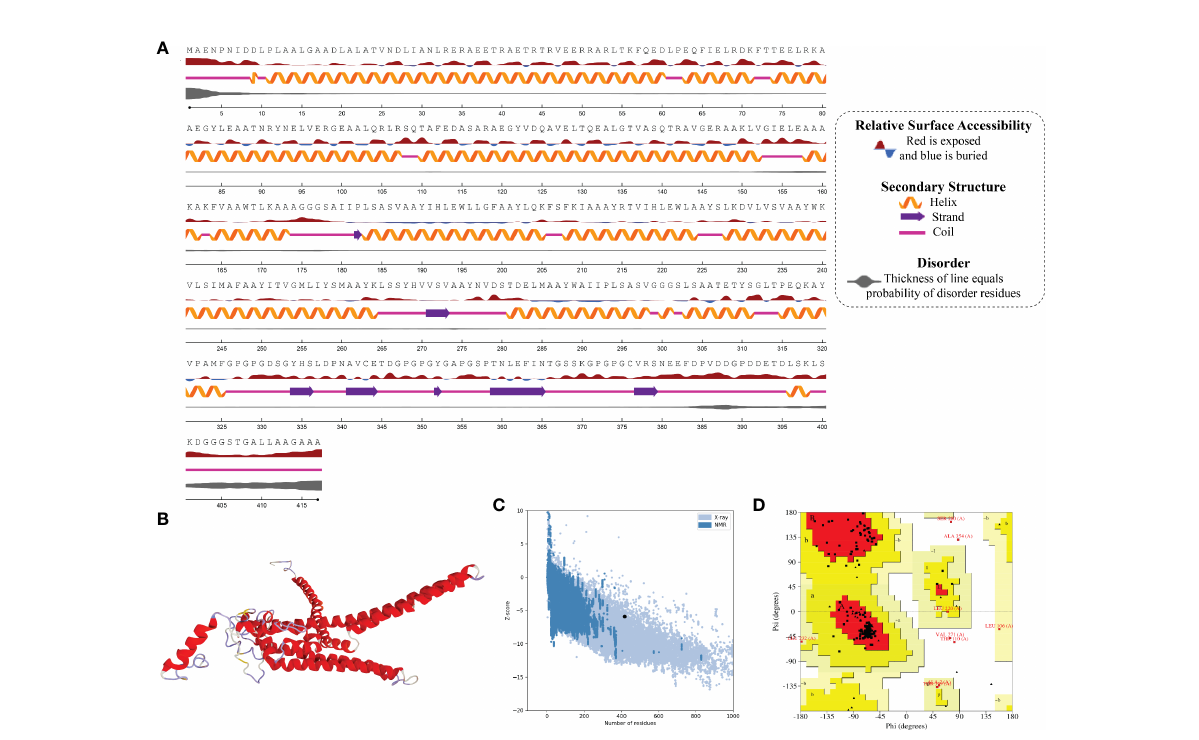
FIGURE 5 Structural analysis and validation of MPXV-3 (A) The predicted secondary structure features, relative surface accessibility, and disorder regions using NetsrurfP-3.0 server (B) Final 3D modeled structure of the constructed vaccine (C) Z-score graph via ProSA-web showing the modeled 3D structure corresponds to X-Ray crystallographic determined structure for the protein of similar sizes (D) Ramachandran plot details of the fi nal modeled structure of designed vaccine.